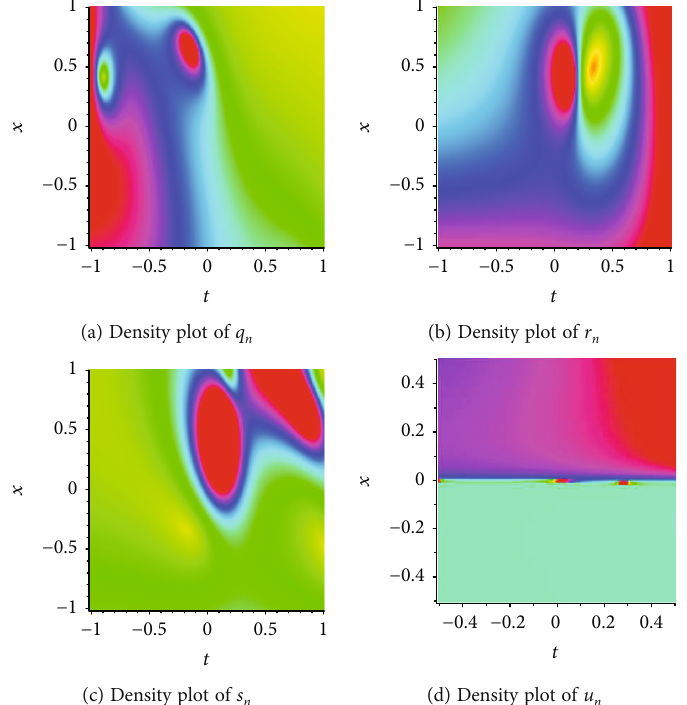
ffiffiffi p 3 I , and κ 2 =